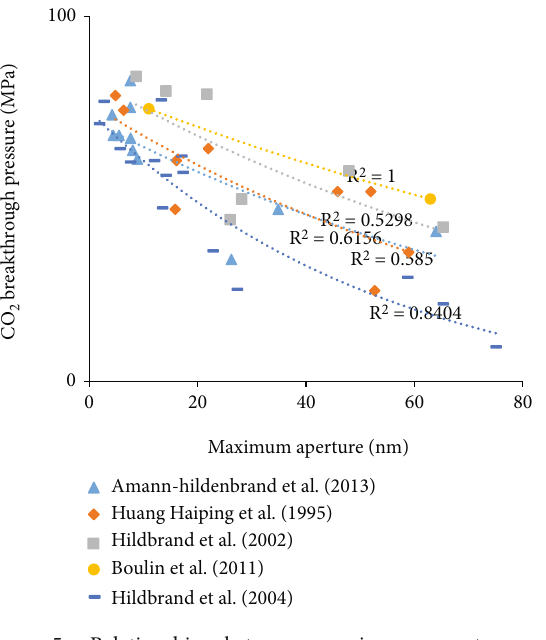
Figure 5: Relationship between maximum aperture and breakthrough pressure of CO